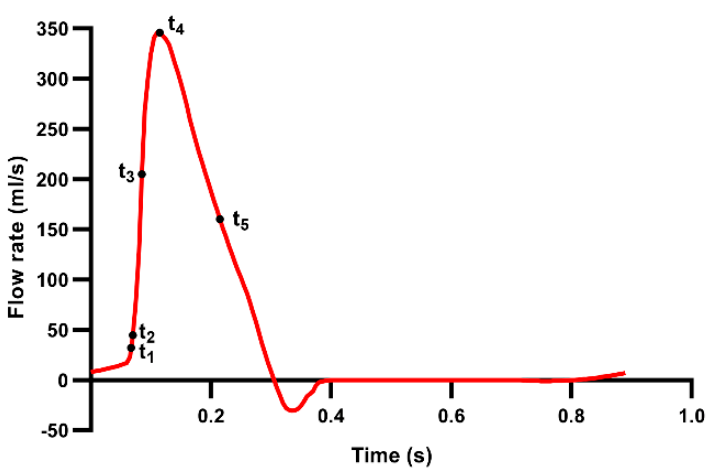
Figure 2. The volumetric flow rates at the selected times points.